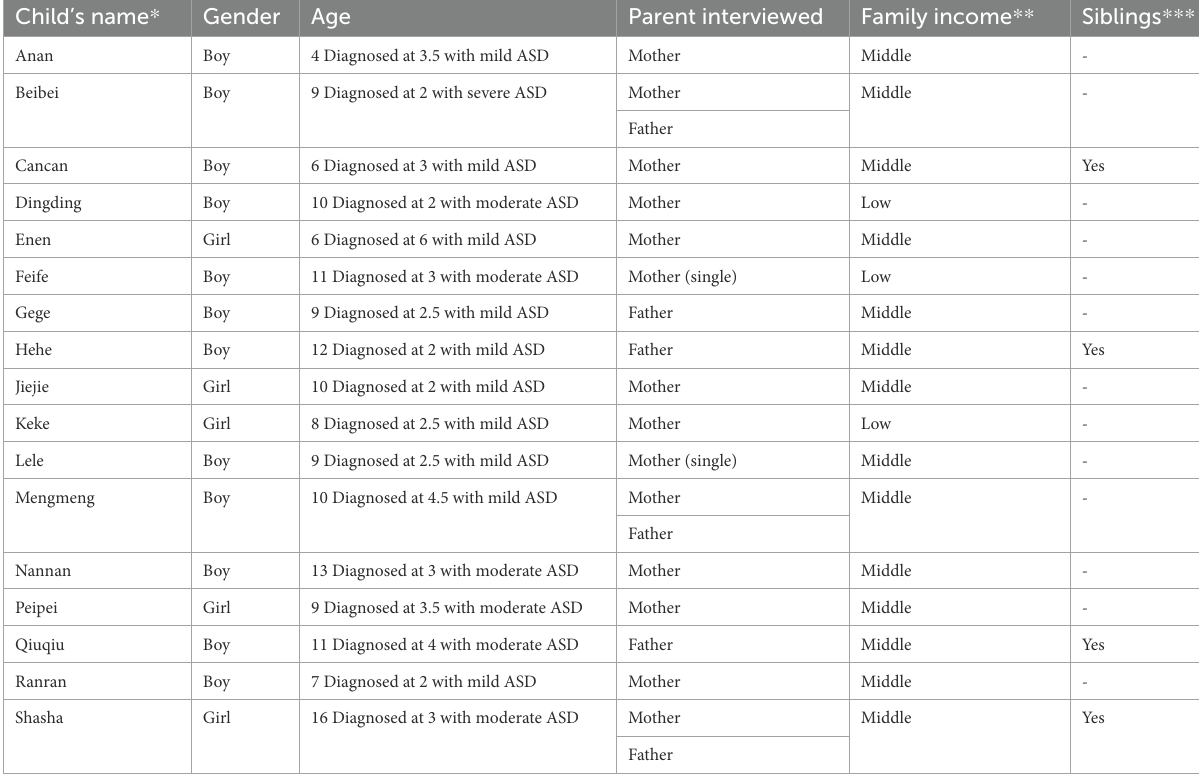
TABLE 1 Characteristics of